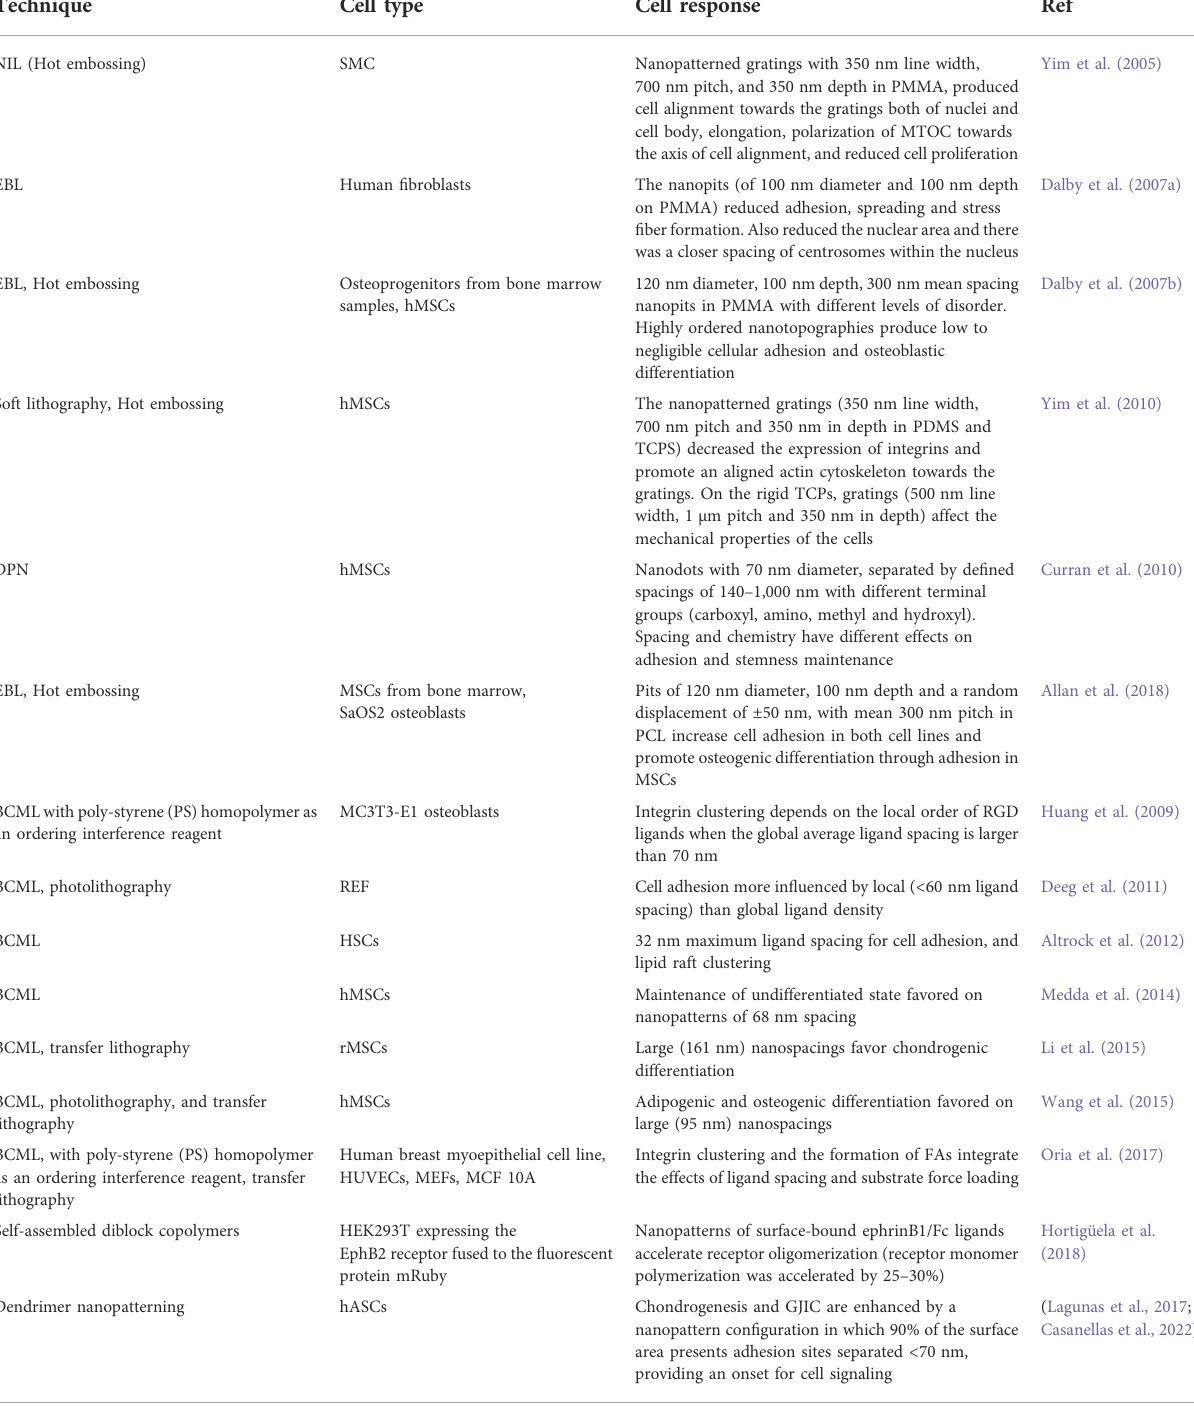
TABLE 1 In fl uence of nanotopographies on cell